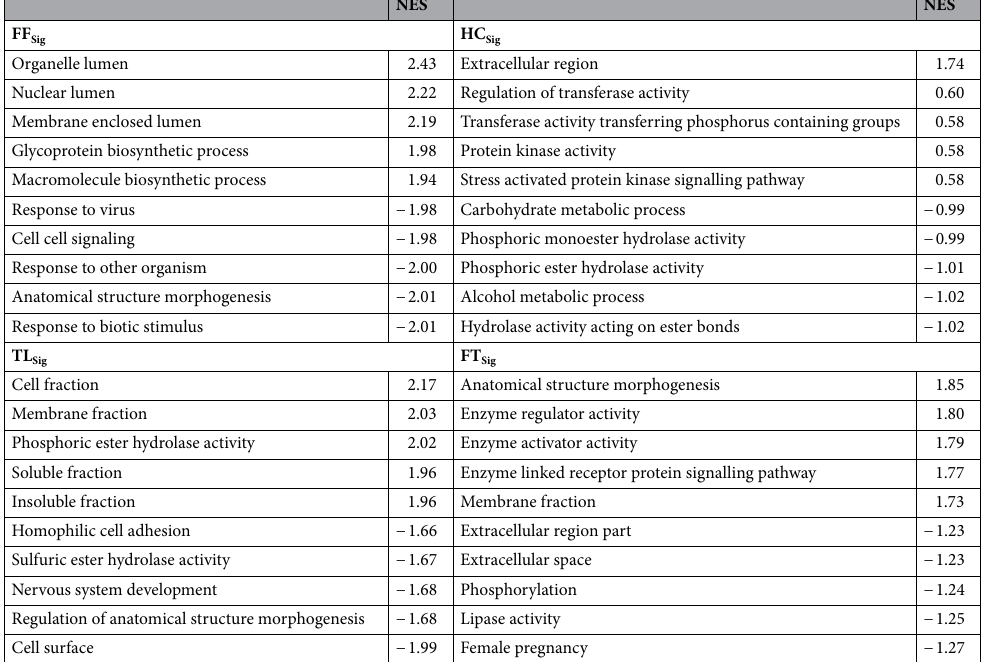
Table 3. The GO terms that have RRs with FF Sig , HC Sig , TL Sig and FT Sig with positive and negative associations from the NRG-H dataset.